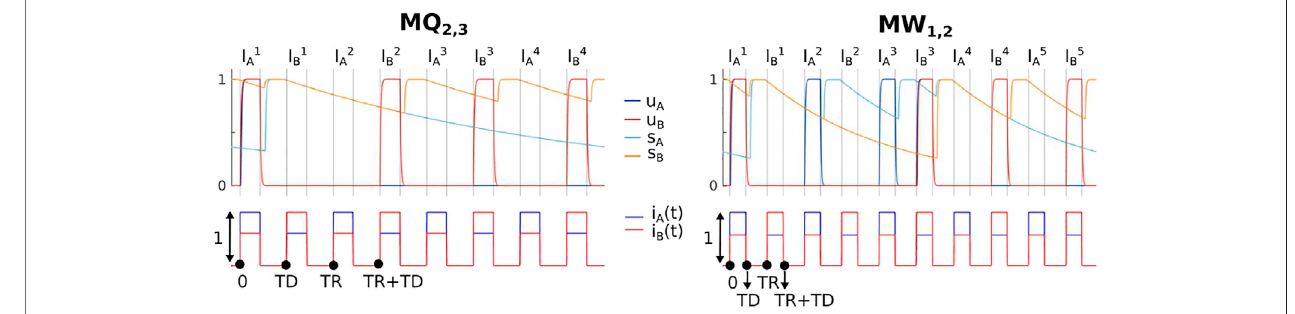
FIGURE 4 | Time history examples of the Q -switching state Q 2,3 and W -switching state W 1,2 . All parameters are the same as in Figure 2 , except for the following: c (cid:2) 2.076, d (cid:2) 0.605 and τ i (cid:2) 0.4 for the left panel; c (cid:2) 2, d (cid:2) 0.57 and τ i (cid:2) 0.2 for the right